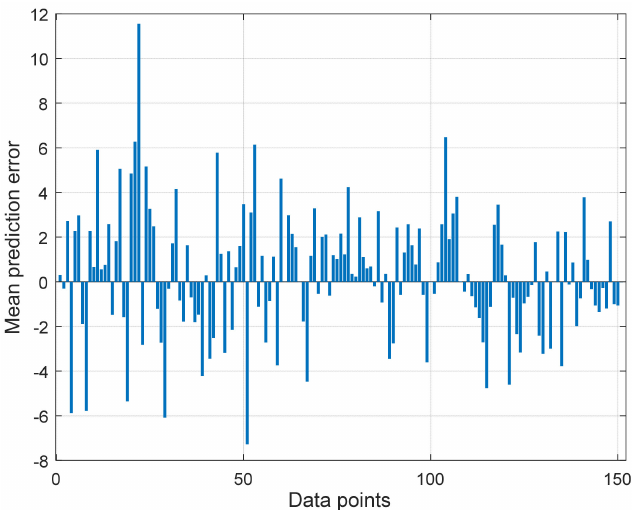
Figure 18. Mean prediction error statistics along with Data points in site